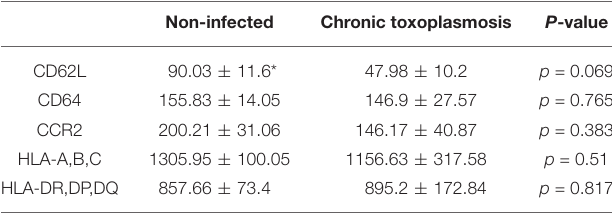
TABLE 1 | Expression of cell surface receptors on monocytes from individuals with chronic toxoplasmosis and non-infected controls.